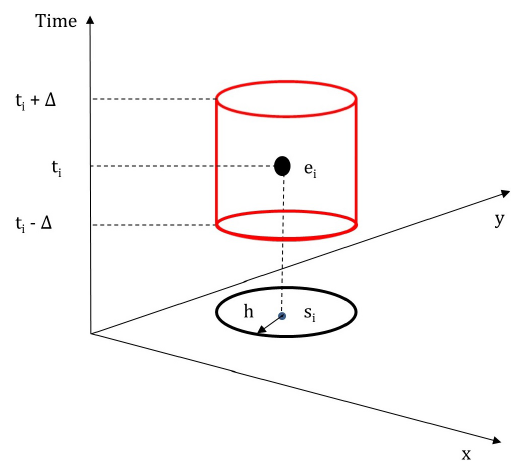
Figure 4. Space–time cylinder neighbourhood (Smith, 2016) for a landslide event ( e i